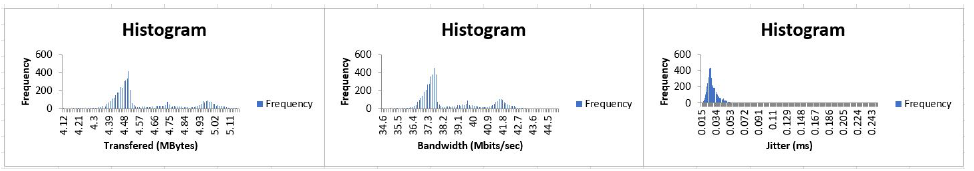
Figure 12. Node 3 with mid data rate utilized bandwidth and jitters.